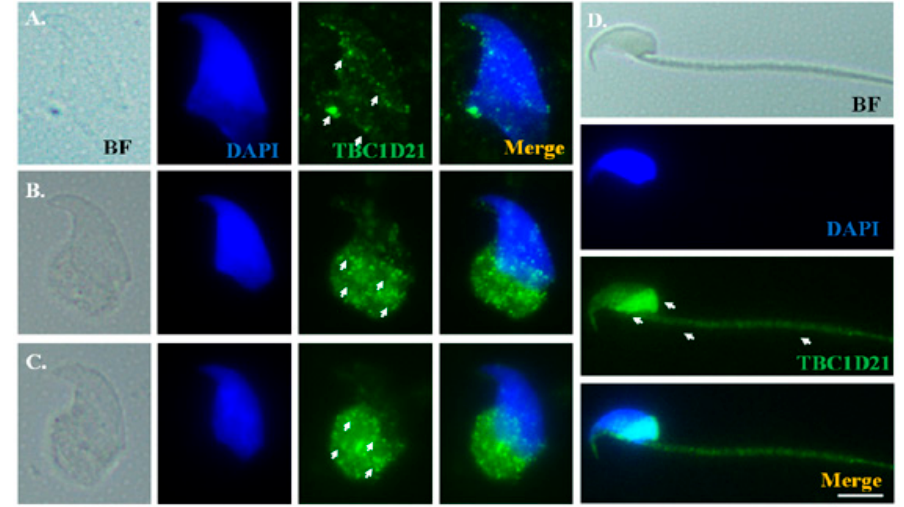
Figure 5. TBC1D21 signals showed multiple localizations during murine spermiogenesis. From left to right: Bright field (BF), DAPI staining (blue), and TBC1D21 signal (green), as well as the merging of TBC1D21 and DAPI at early elongation ( A ) and late elongation ( B ), early elongated spermatids ( C ), and mature sperm ( D ). Arrows indicate TBC1D21 signals. Scale bar: 5 μ m. 2.4. Rap1 Is Regulated by TBC1D21